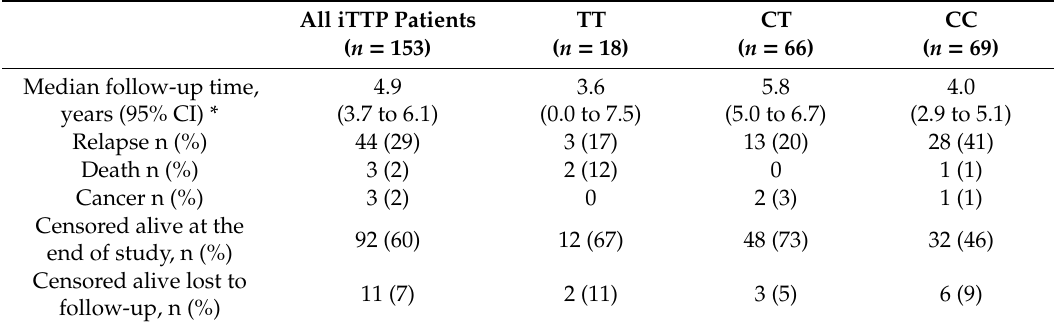
Table 6. Follow-up characteristics of iTTP patients included in the cohort study.